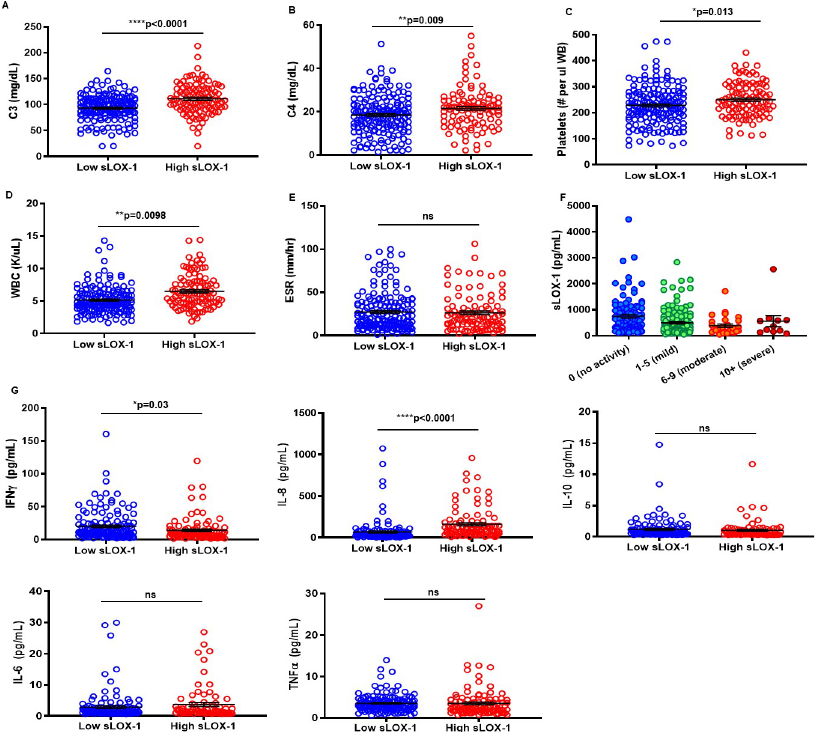
Fig 2. Relationship between sLOX-1 and SLE-related complement levels, platelets, WBC, erythrocyte sedimentation rate (ESR), SLEDAI scores and cytokines. Stratification of lupus clinical and serological parameters based on low and high sLOX-1 levels. Measurement of Complement (A) C3 mg/dL (93.12 ± 1.873, n = 171 versus 111.1 ± 2.95, n = 102) and (B) C4 mg/dL (18.48 ± 0.69, n = 171 versus 21.53 ± 0.9336, n = 102), (C) platelets (228.1 ± 5.718 (#/uL whole blood), n = 171 versus 249.7 ± 6.524, n = 103), (D) WBC (5.157 ± 0.1567 (K/uL), n = 170 versus 6.51 ± 0.2547, n = 102), (E) ESR mm/hr (27.21 ± 1.689, n = 169 versus 26.33 ± 2.127, n = 101) low sLOX-1 versus high sLOX-1 mean and SEM. (F) sLOX-1 levels binned by SLEDAI score. Bars represent mean ± SEM sLOX-1 values for no (745 ± 67.95 n = 104), mild 495 ± 46 n = 127), moderate (383.4 ± 65.41 n = 29) and severe (558.1 ± 210.9 n = 11) disease activity. (G) Cytokines IFN- γ , IL-8, IL-10, IL-6 and TNF- α were measured by multiplex MSD ELISAs from SLE patients in the low sLOX-1 (n = 141) and high sLOX-1 (n = 101) groups. � p < 0.05, �� p < 0.01, ��� p < 0.001 and ���� p <